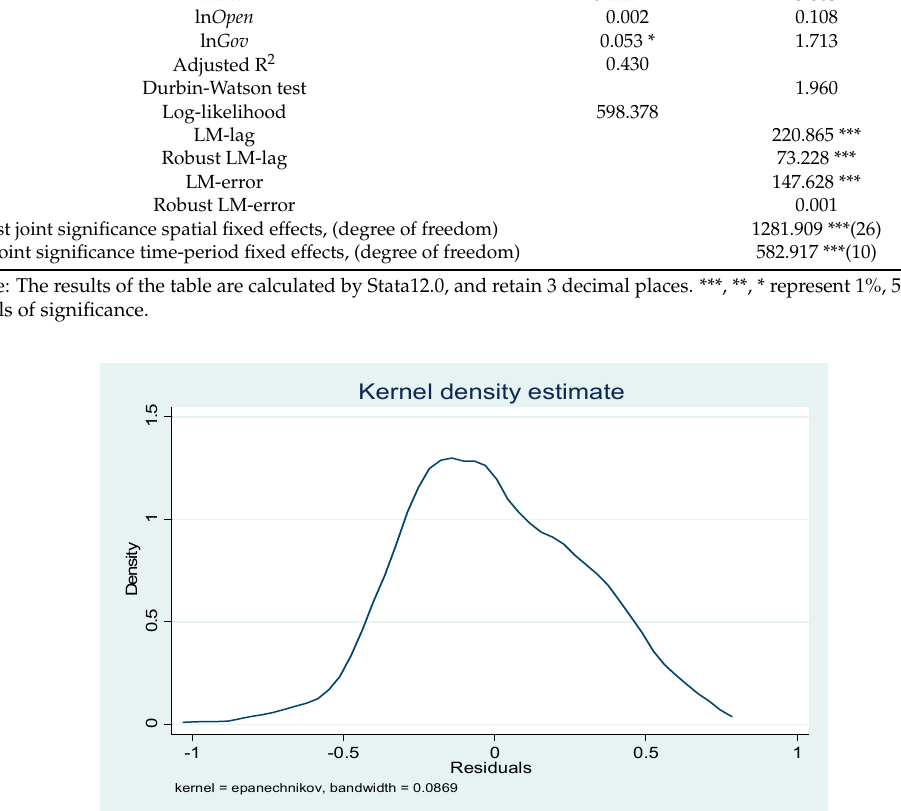
Table 7. Estimated results of spatial econometric models.